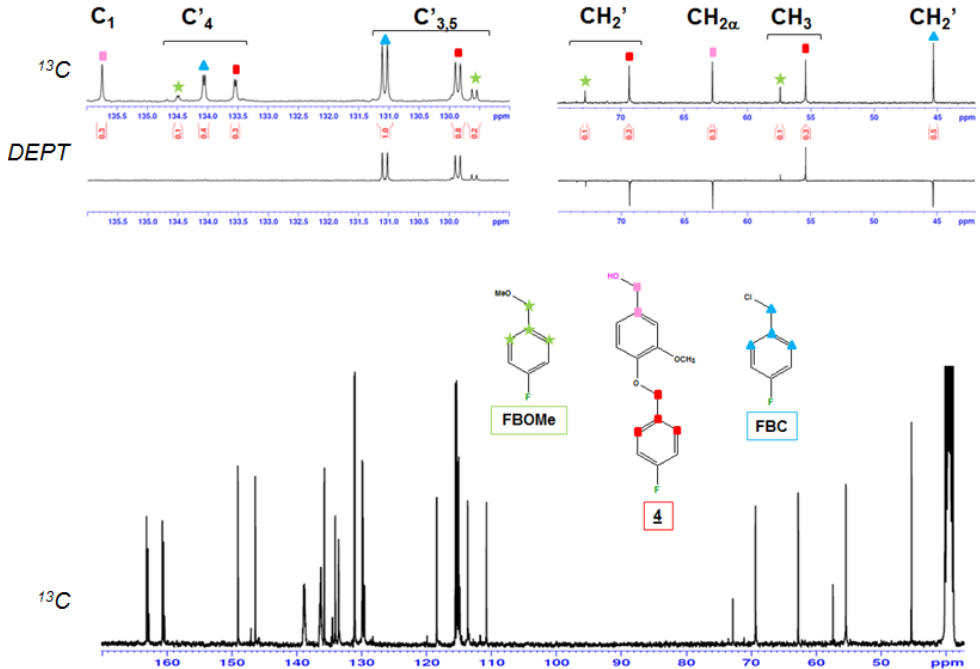
Figure 5. 13 C-NMR spectra of the mixture issued from the fluorobenzylation of vanillyl alcohol ( 4 ) in DMSO-d6.